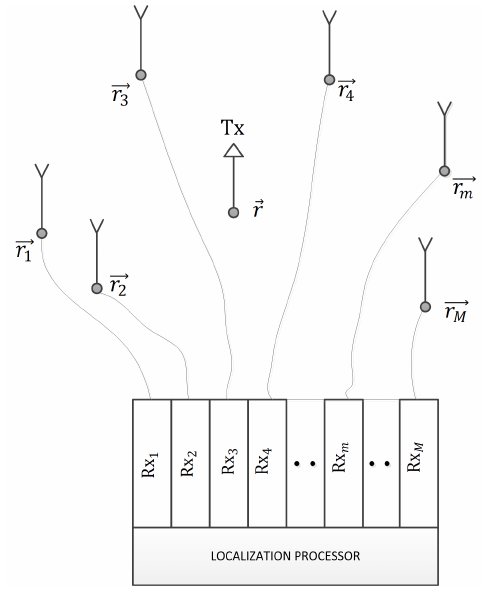
Figure 1. The system